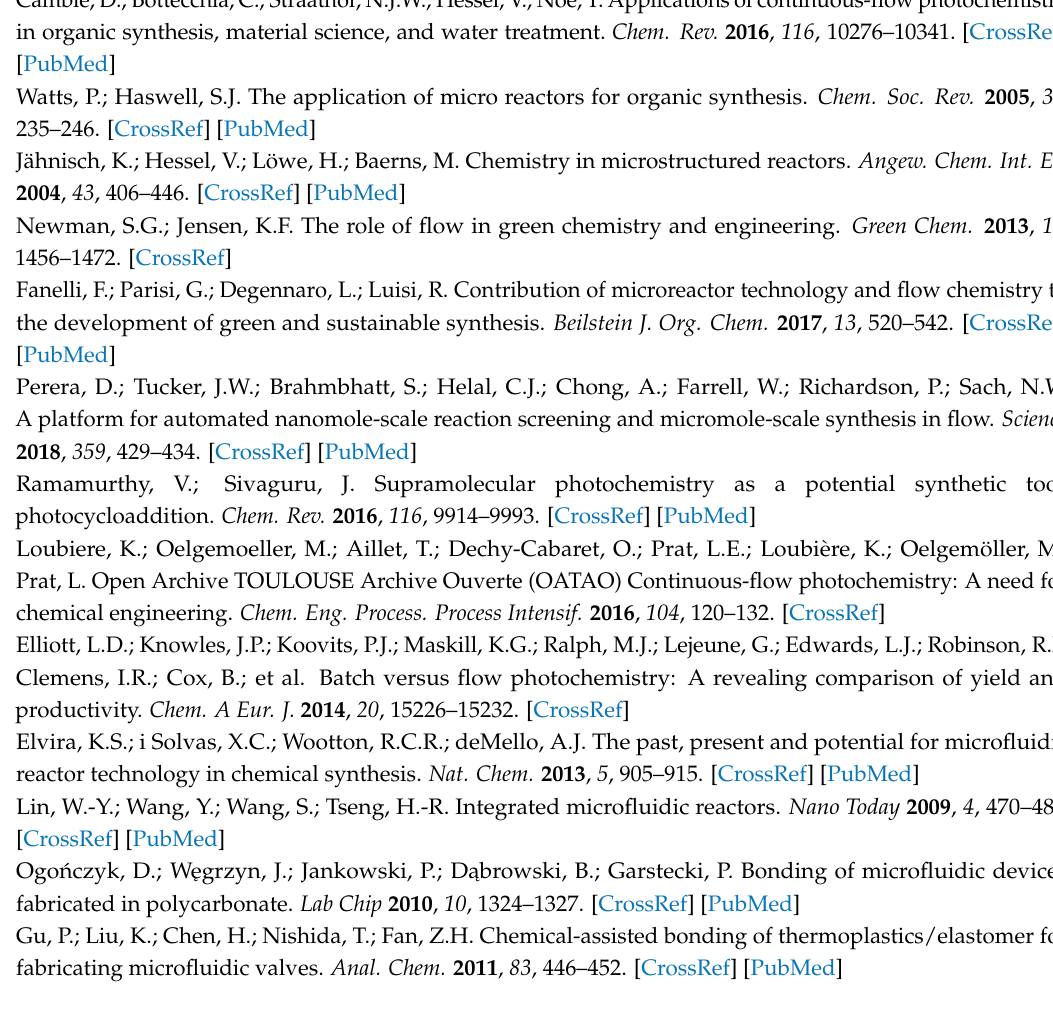
Figure S1: Experimental setup for measuring density of power; Figure S2: The density of power as a function of the power of the UV diode; Figure S3: The density of power as a function of the power of the UV diode, where the gap between UV diode and the sensor is simply an air, or fluorinated ethylene propylene (FEP) plates; Figure S4: CAD scheme of the FEP microreactor used in experiments; Figure S5: The experimental setup to measure the maximal working pressure; Figure S6: To test initial mixer we run acetonitrile and acetonitrile with a dye (Oil Blue); Figure S7: The experimental setup for photochemical reaction; Figure S8: Direct visualisation of the flow of EtOH with Oil Blue in FEP microreactor; Figure S9: The 1 H nuclear magnetic resonance (NMR) spectrum of the product of bromination reaction; Figure S10: Complete chromatogram for bromination reaction for three different flow rates; Figure S11: The 1 H NMR spectrum of the product of thiol-ene